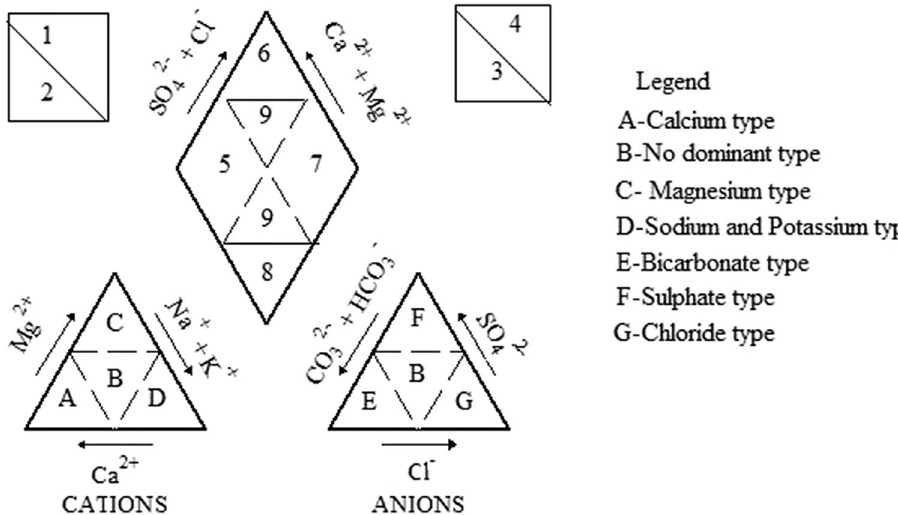
Fig. 3 Classification of